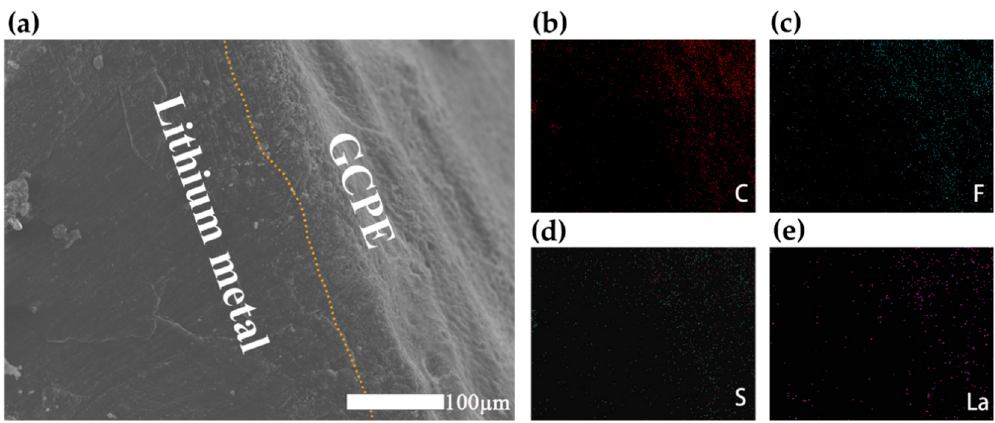
Figure 2. ( a ) Cross section SEM of GCPE/Li. ( b – e ), EDS mapping of C, S, F, La for